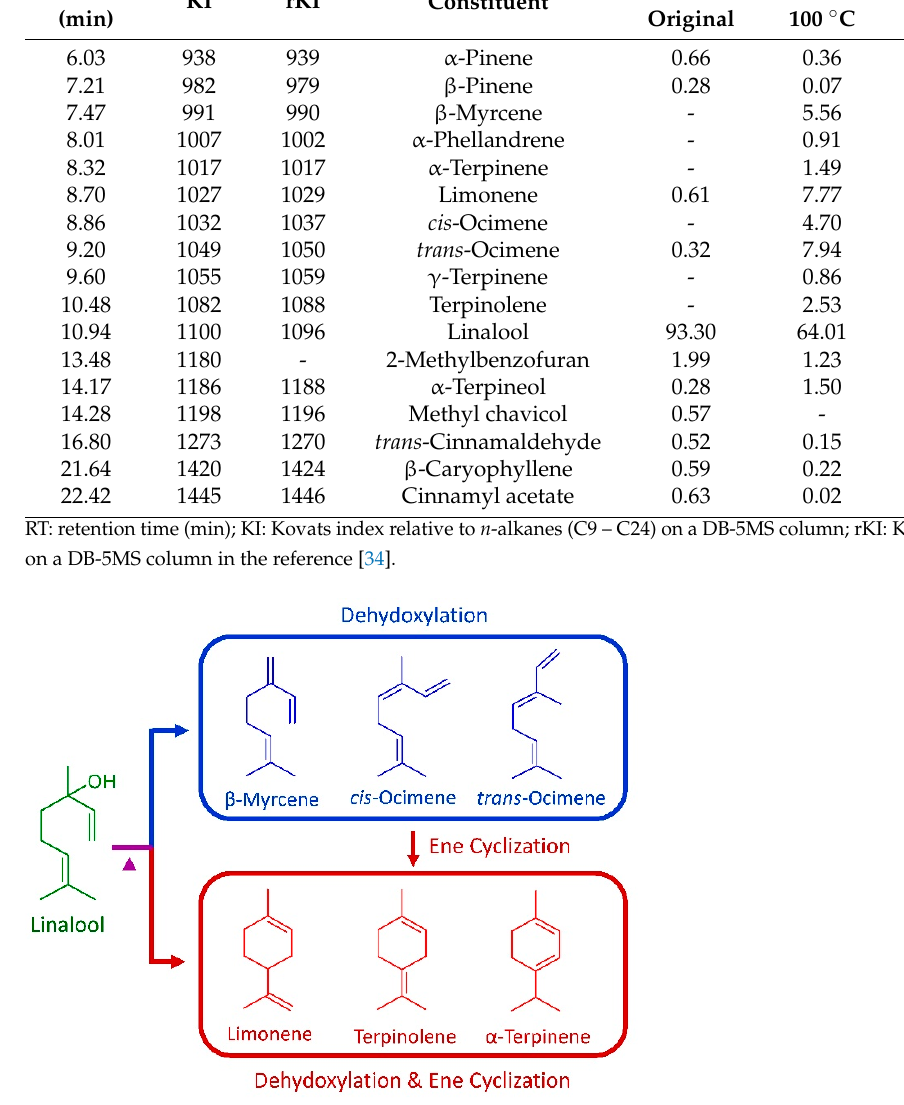
Figure 2. Schematic illustration of the thermal degradation of linalool.